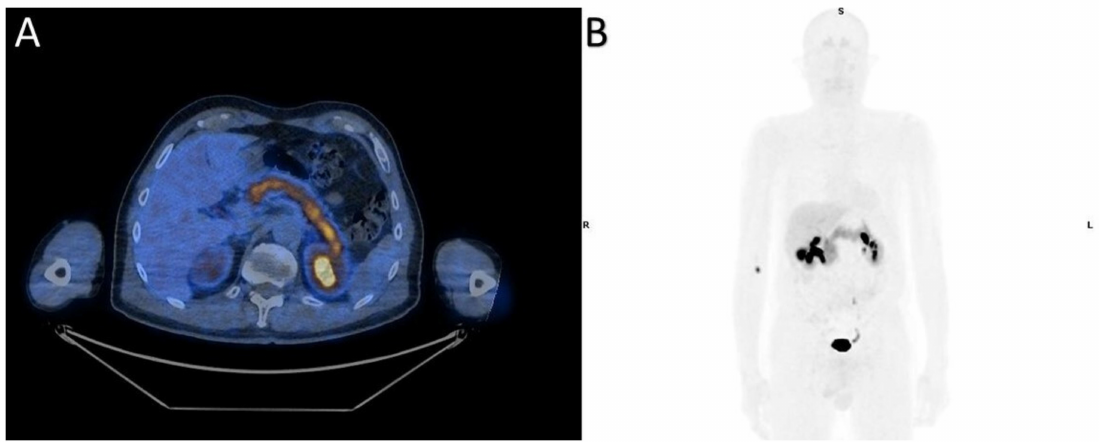
Figure 3. [ 18 F]FDOPA PET / CT transaxial images ( A ) and MIP ( B ) show di ff use physiological uptake in the